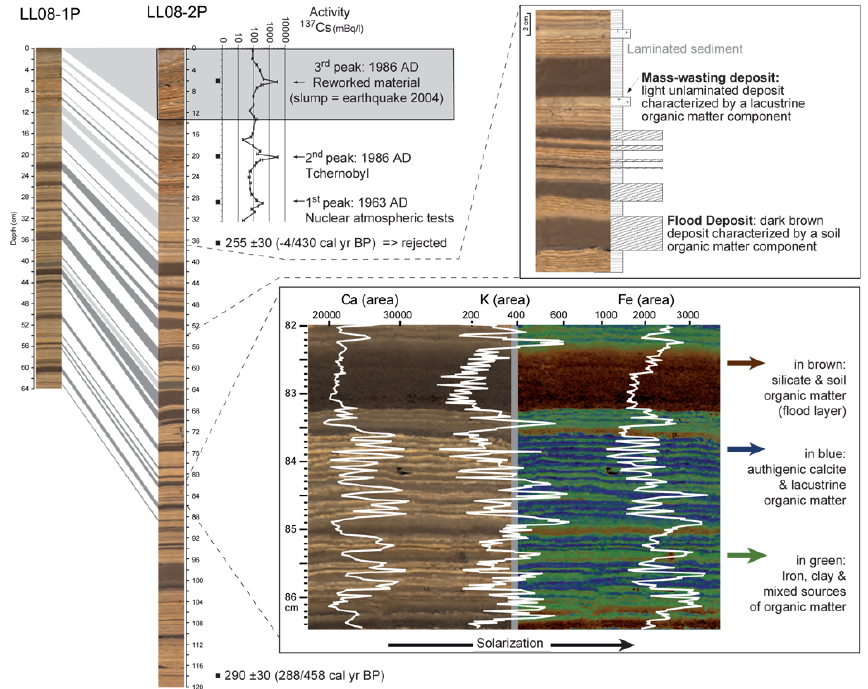
Fig. 2a. Sediment core images, 137 Cs measurements and radiocarbon dates from gravity cores (1P and 2P) sampled at sites of cores LL08-1 and LL08-2. Visual inspection of the cores from Lake Ledro shows a laminated yellow-grey sediment (background sediment) interspersed with fine-grained brown units that are usually rich in terrestrial organic matter corresponding to allochthonous event layers or flood deposits (FD; bottom zoom-box). Unlaminated mass-wasting deposits (MWD) were also identified and could be easily distinguished from FD by their light colour and their lacustrine organic component (top zoom-box). All of these deposits are considered to be instantaneous and were removed from the age-depth models (Fig. 4). Solarisation is an effect used in photography that causes an image recorded on a negative to be reversed in